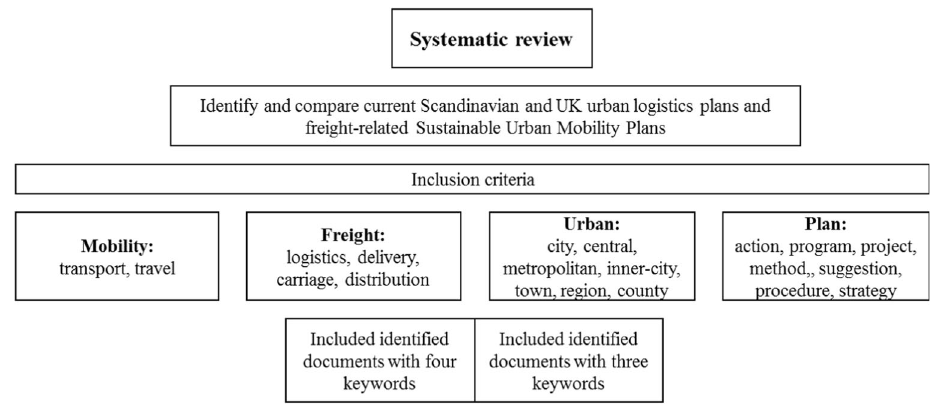
Fig. 1 Inclusion criteria of selected urban-freight-related